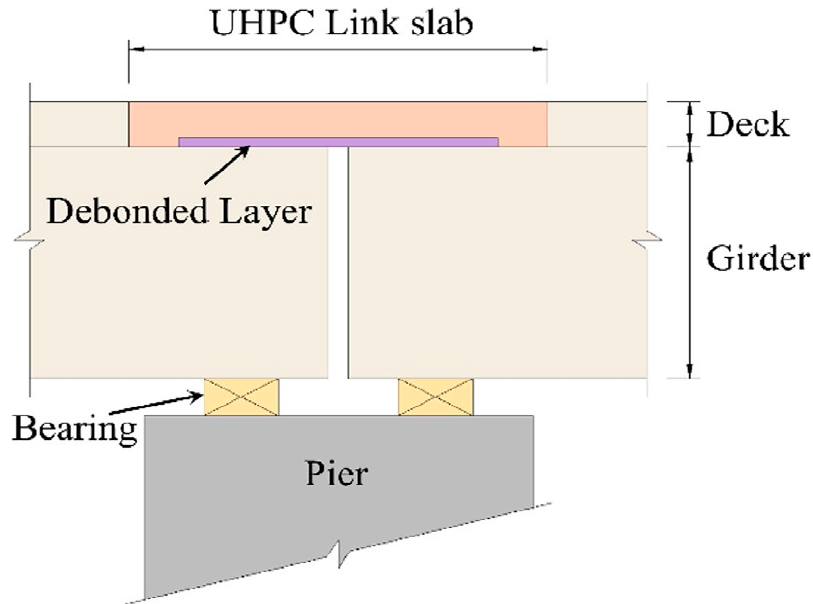
Figure 6. Representative apps of UHPC in joint connection BEs [138] .